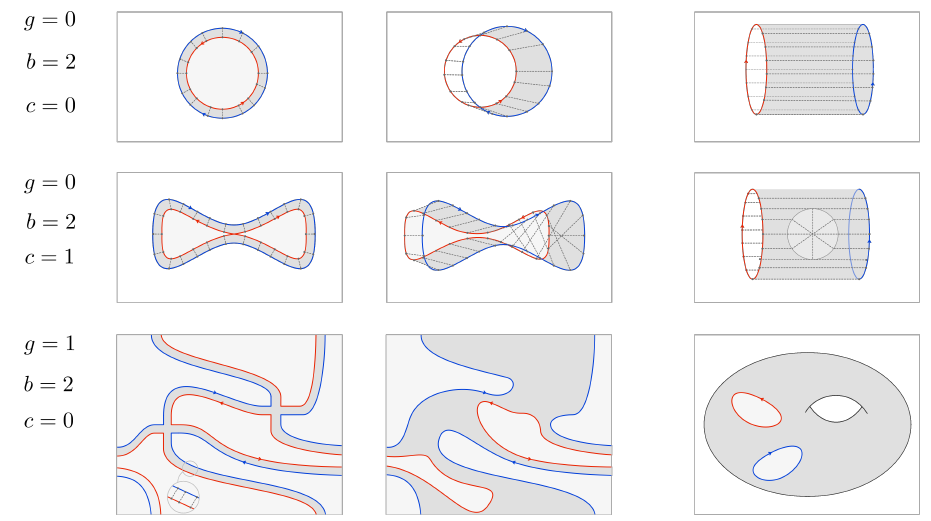
Figure 6: Impurity diagram representation of the perturbative surface to bulk corre- spondence. Each line is labelled by the genus g , the number of boundaries b and the number of crosscaps c . Discussion, see